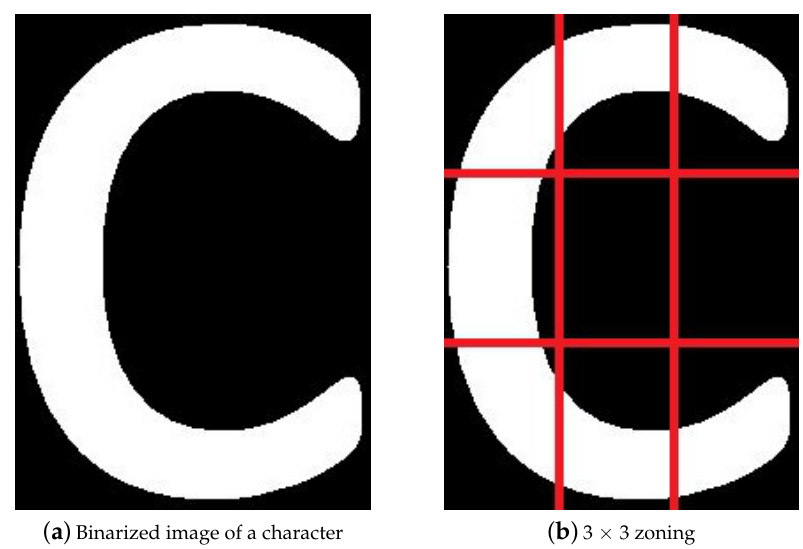
Figure 6. Overview of zoning of an image into